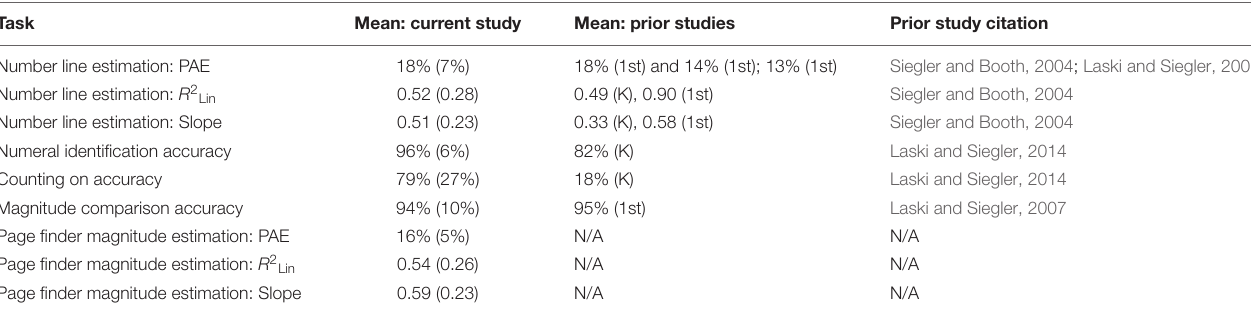
TABLE 2 | Average performance in current and prior